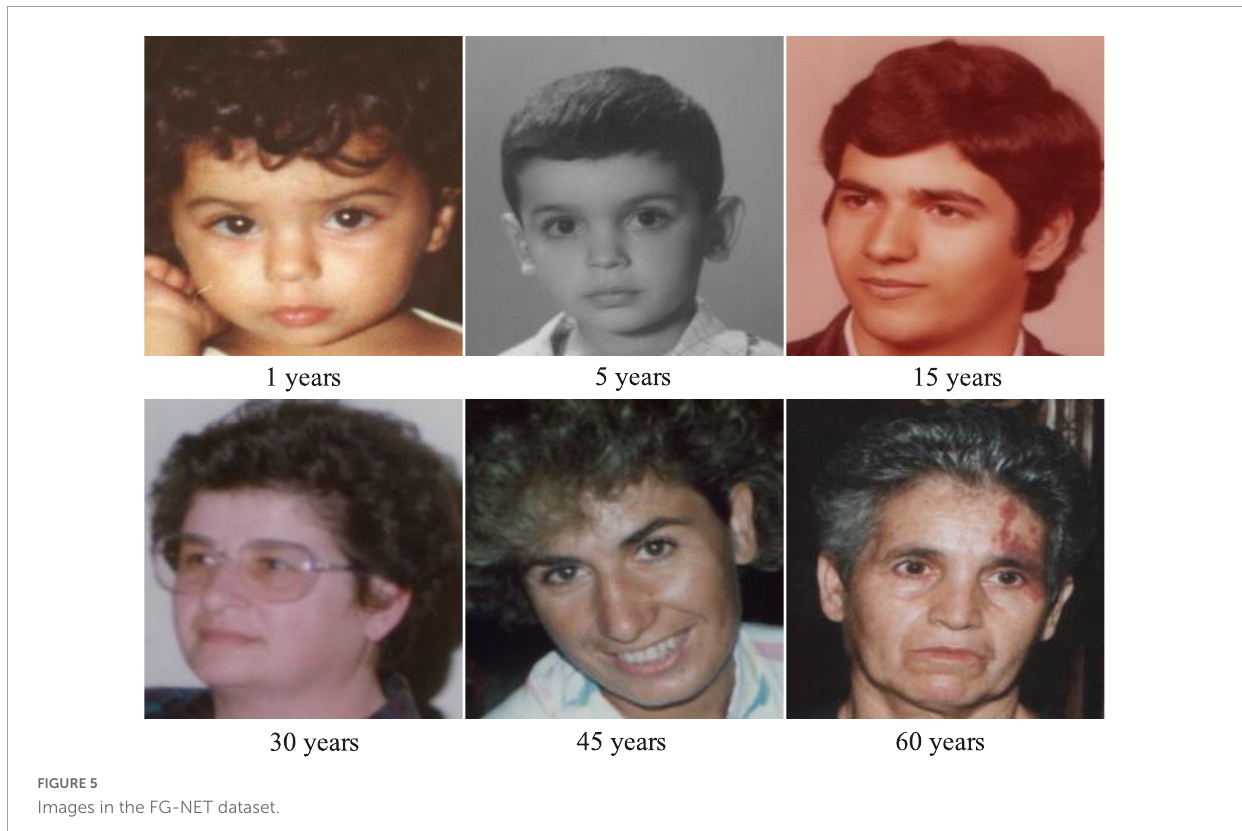
FIGURE5 Images in the FG-NET dataset.